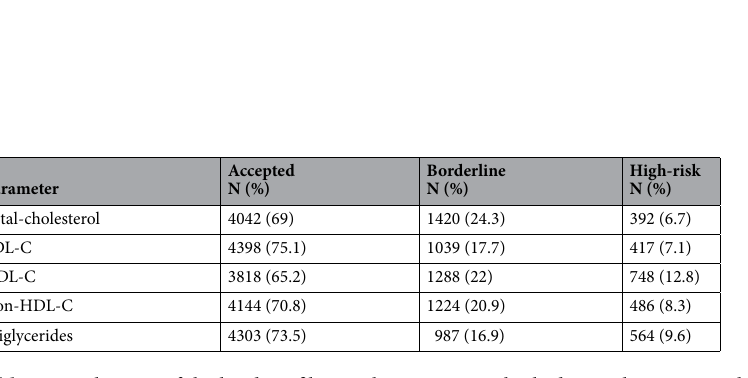
Table 2. Evaluation of the lipid profile panel tests. HDL-C high-density lipoprotein cholesterol, LDL-C low- density lipoprotein cholesterol, Non-HDL-C non-high-density